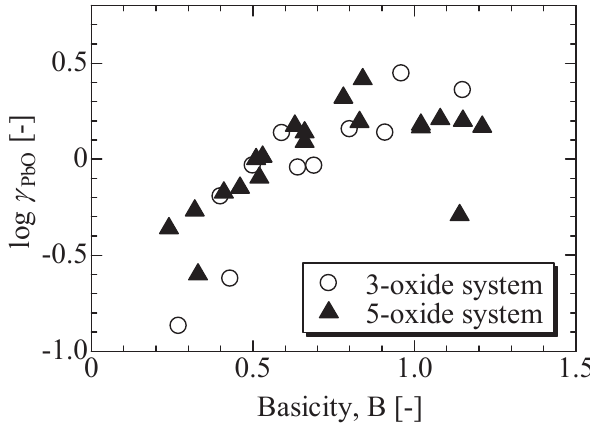
Figure 3. Comparison of the PbO activity coefficient be- tween the 3- and the 5-oxide systems; the 3-oxide system refers to CaO-SiO 2 -Fe t O and the 5-oxide system refers to CaO-SiO 2 -Fe t O-Al 2 O 3